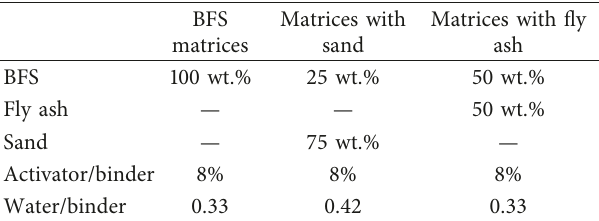
Table 3: The mixture design of prepared matrices.